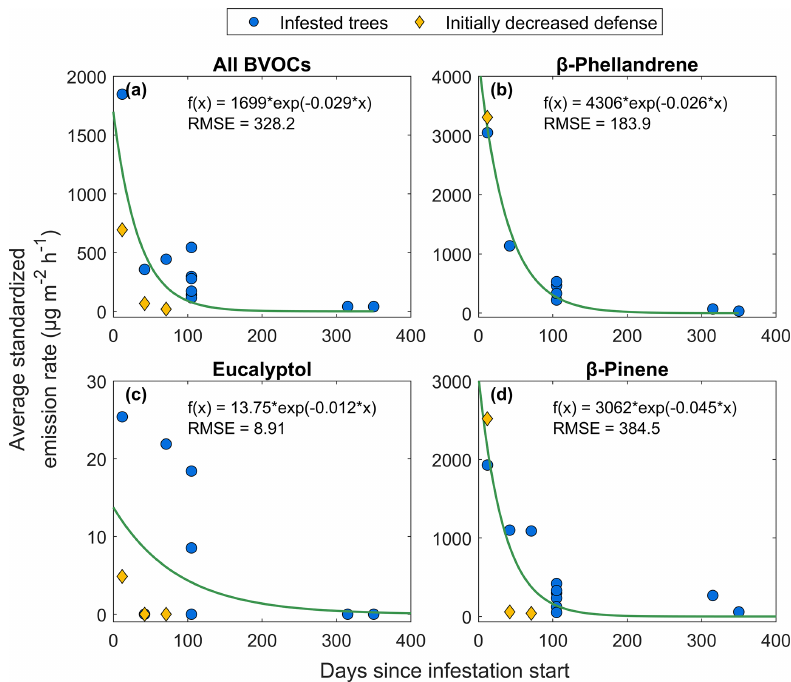
Figure 8. The relationship between average temperature standardized emission rate from all infested Norway spruce trees (blue circles) in Hyltemossa and Norunda and the number of days since infestation start for (a) the average of all BVOCs, (b) β -phellandrene, (c) eucalyptol and (d) β -pinene. An exponential curve was fitted to the data according to Eq. (6) (green lines). All trees are included in the exponential fitted curve; however one tree had initially lowered defense and is marked specifically in the figure (yellow diamonds).